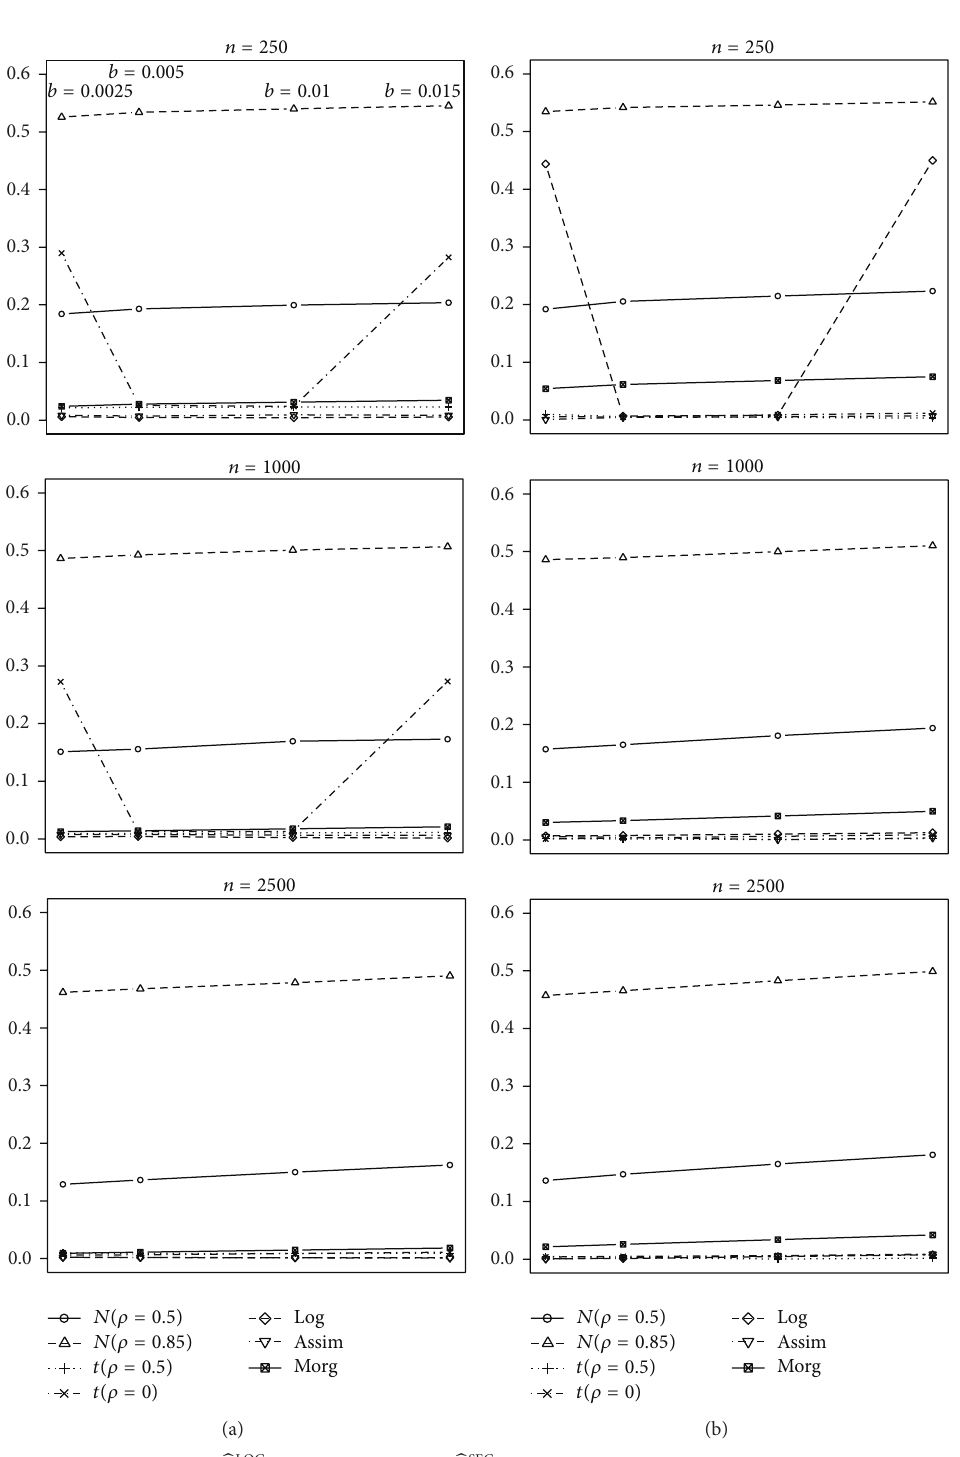
Figure 2: Absolute bias of estimator 0.0025, 0.005, 0.01, 0.015 , respectively.